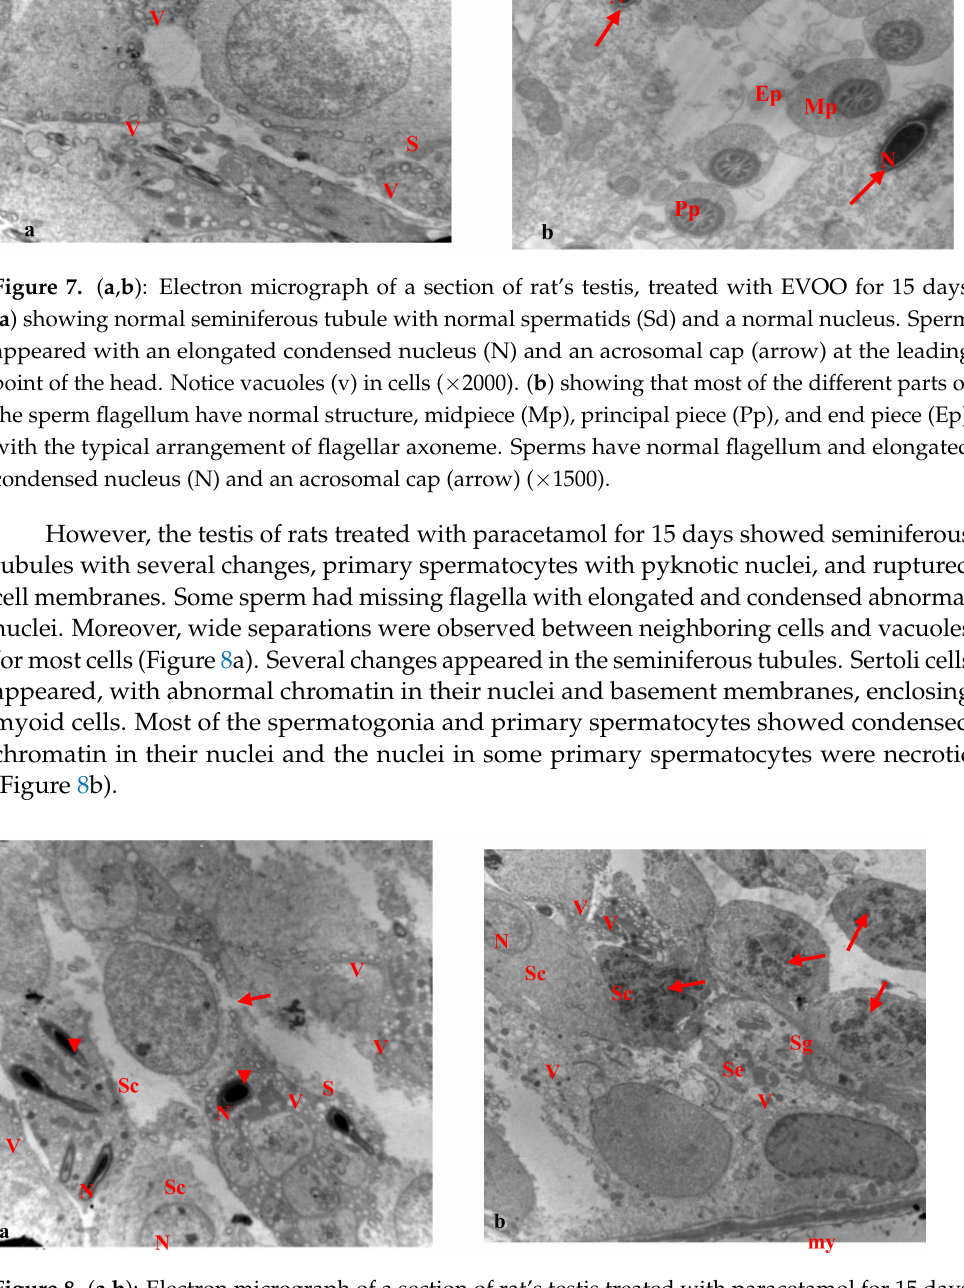
Figure 8. ( a , b ): Electron micrograph of a section of rat’s testis treated with paracetamol for 15 days. ( a ) showing seminiferous tubule with several changes, primary spermatocytes (Sc) with pyknotic nucleus (N), and the rupture of the cell membrane (arrow). Some sperm without flagellum (head arrow) and elongated condensed abnormal nucleus (N). Notice the wide separation (s) between neighboring cells and vacuoles (v) in most cells ( × 1500). ( b ) showing seminiferous tubules with several changes, Sertoli cell (Se) appeared with abnormal chromatin in nucleus (N), and the basement membrane enclosing myoid cell (my). Most of the spermatogonia (Sg), and primary spermatocytes (Sc) with chromatin condensation in their nucleus, primary spermatocytes (Sc) with necrotic nucleus (N). Notice vacuoles (v) in cells ( ×